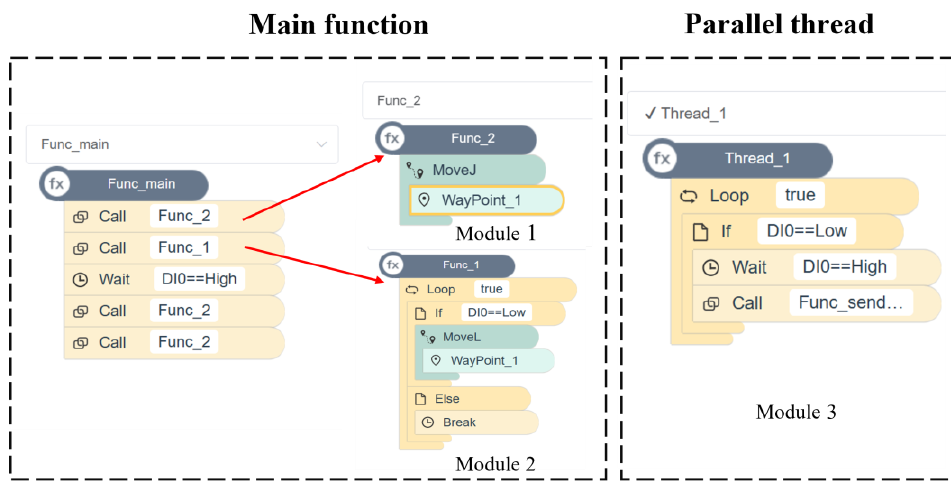
Figure 7. Components of the measurement program.